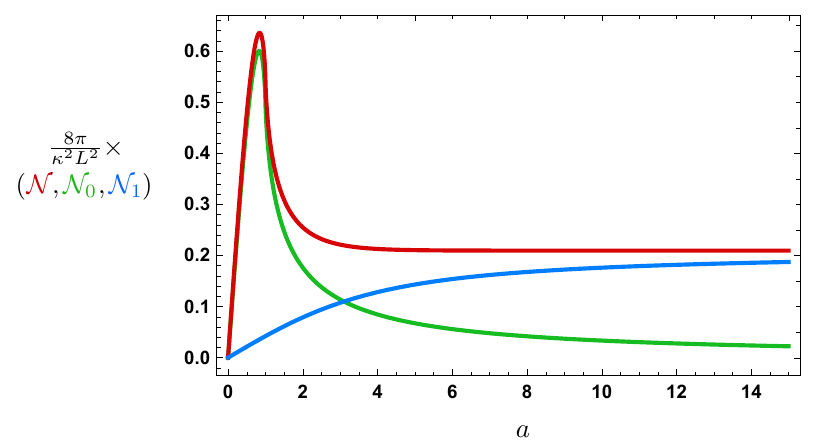
from eq. (4.1) in terms of the rescaled time a = t=L . D